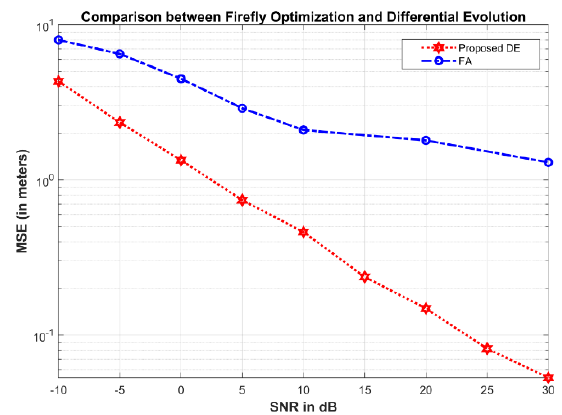
Figure 6. The deviation in MSE with SNR.